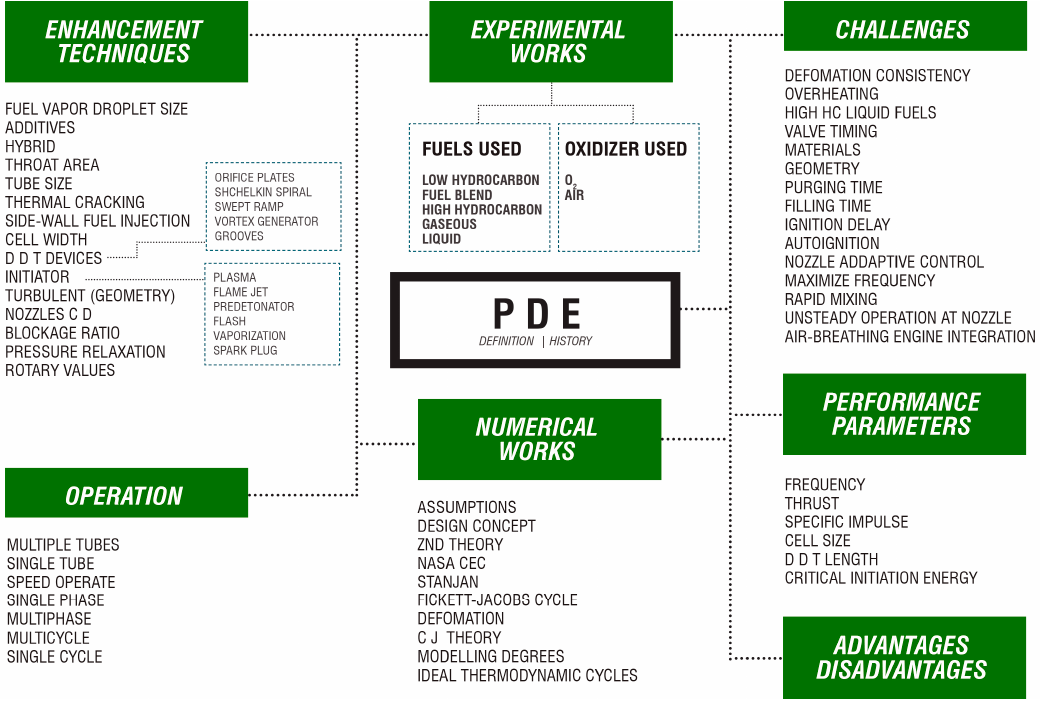
Figure 2. Overview of pulse detonation engines (PDE).